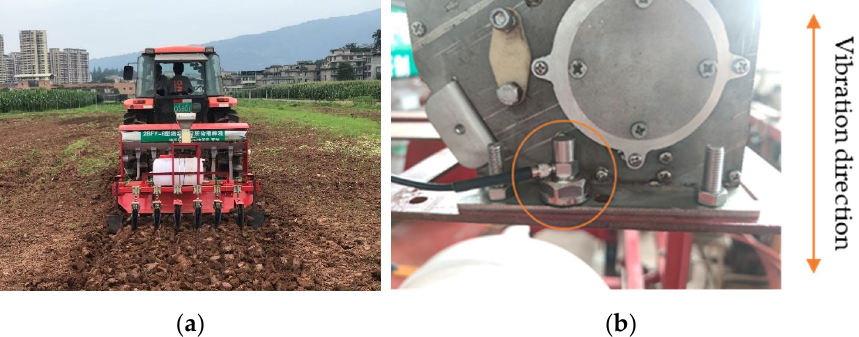
Figure 5. ( a ) Field vibration test of the 2BFY ‐ 6 type combined rapeseed seeder, and ( b ) installation position of acceleration sensor.